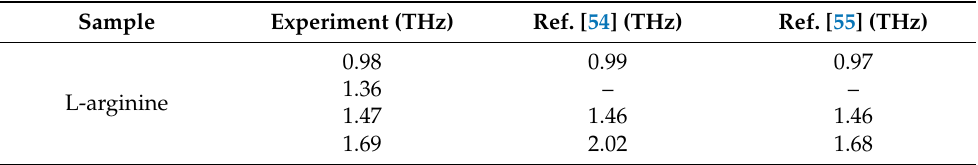
Figure 5. Experimental spectrum of L-arginine suspension, which was obtained by the THz-TDS system with a strong-filed THz source and a polyethylene sample cell. The A:A H label indicates the ratio of the spectrum of L-arginine suspension to the spectrum when water is used as reference. Table 1. The absorption peaks of L-arginine suspension in this experiment and the absorption peaks of L-arginine solid in